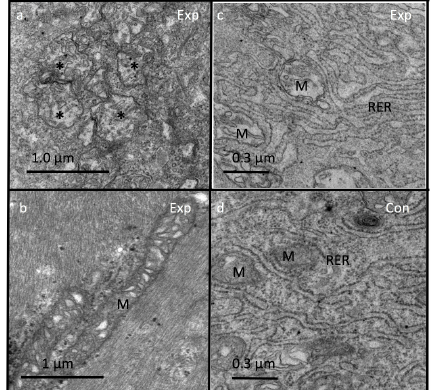
Figure 10. Ultrastructure of blastema from experimental tadpoles after 5 days showing fusion of damaged mitochondria (M) with near loss of cristae (Figure 10a) and often very long mitochondria due to fusion (Figure 10b). Mitochondria (M) from plasma-exposed tadpoles have an electro-lucent matrix (Figure 10c) compared to control (Figure 10d). Note close proximity of endoplasmic reticulum (RER) and mitochondria in both of the groups (Figure 10c,d). Exp-experimental;